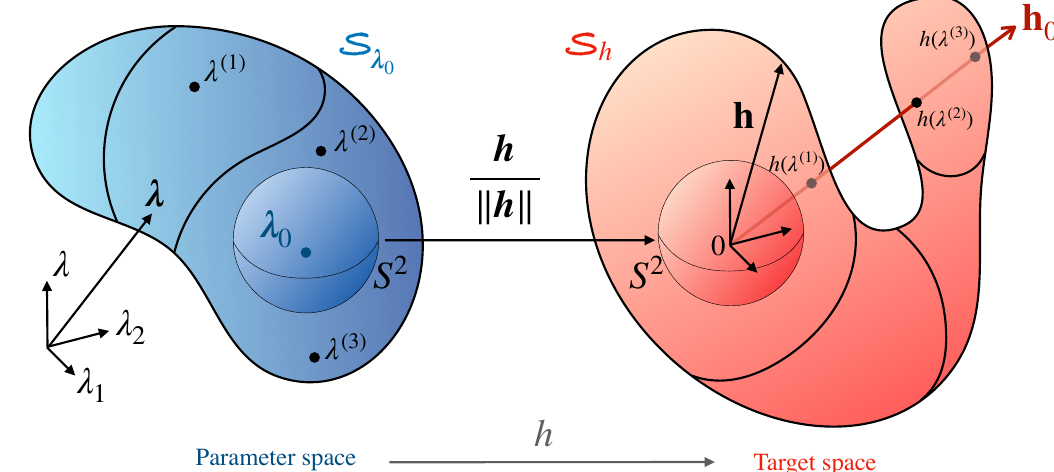
Figure 6: Sketch of the Hamiltonian map h between the parameter space and the target space. The degree of h is defined when considering the image that encloses the degeneracy point λ λ S 0 of pre-imagines that enter the formula (79) of the